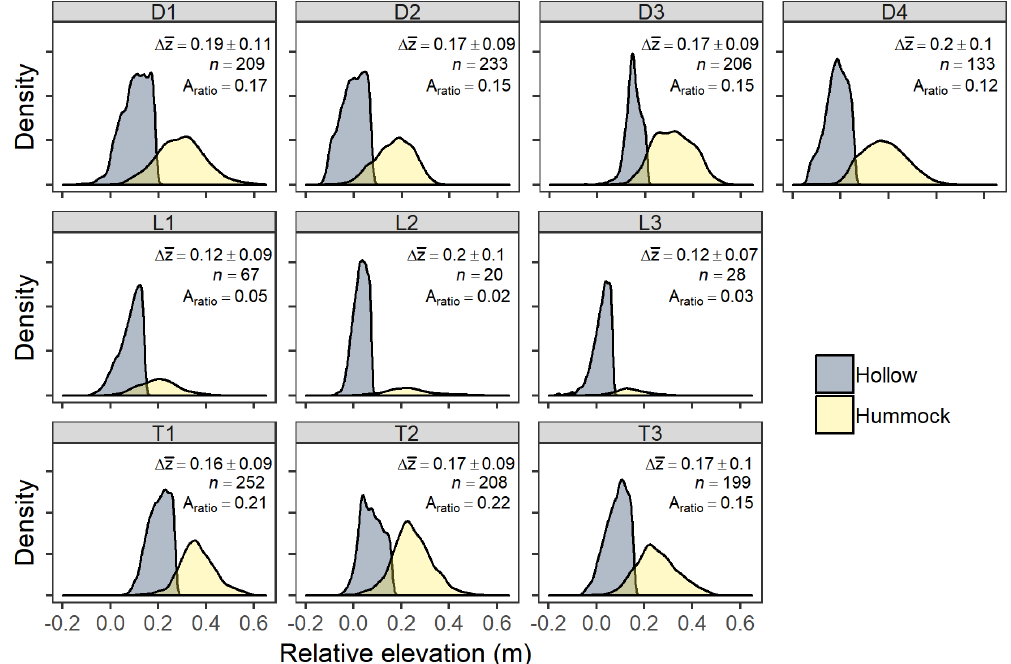
Figure 5. Relative elevation probability densities for each site, colored by hummock and hollow. The text indicates the difference in mean elevation ( (cid:49)z ; m) between hummocks and hollows at each site ( ± SD – standard deviation), the total number of hummocks identified at each site ( n ), and the ratio of hummock area to total site area ( A ratio ). Depression sites (D) occupy the top row, followed by lowland sites (L), and transition sites (T). Elevations are relative to the base of the well at each site, which was approximately the lowest elevation at each